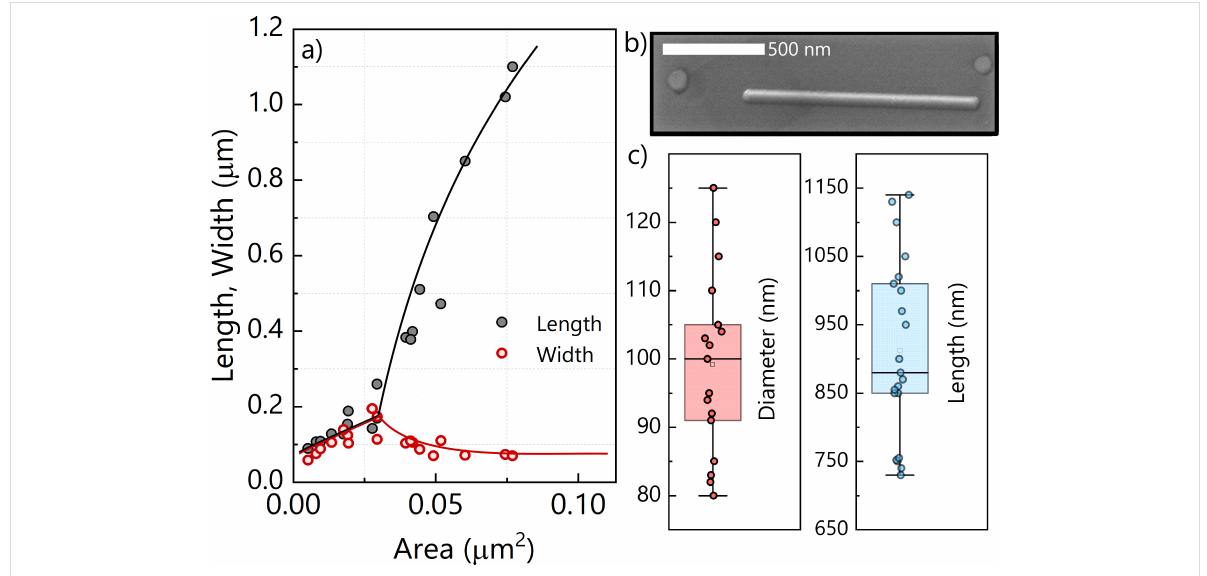
Figure 7: (a) Length ( t ) and width ( s ) of Mn 5 Ge 3 islands, formed on the sample surface of the 4.5 ML thick Mn layer upon annealing at 650 °C for 15 min, as functions of the island area. Deviation from a regular island shape (diverging branches) occurs at s = t ≈ 170 nm. At area values of ≈ 0.075 μ m 2 , the width approaches the optimal value of s ≃ 80 nm (red line) while the length continues to grow (black line). Lines are guides to the eyes. (b) SEM image of the typical morphology of a NW (after annealing for 30 min at 650 °C) to facilitate the comparison with experiment. (c) Diame- ter and length distribution of NWs (conditions similar to that in (b)). The whiskers show the minimum and maximum value of NW dimensions, while the colored boxes show the 25th and 75th percentile of the distribution with the middle line representing the average